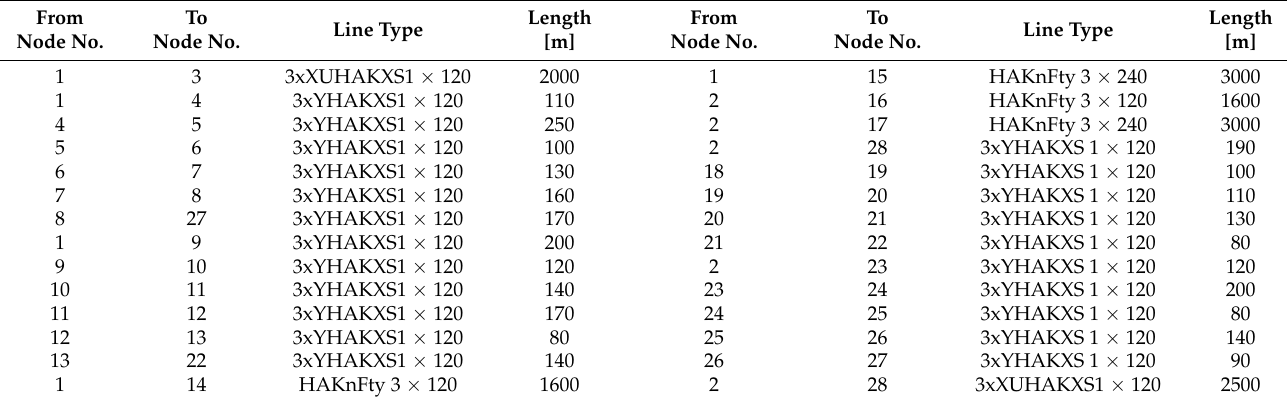
Table A2. Line parameters of the urban MV distribution network.